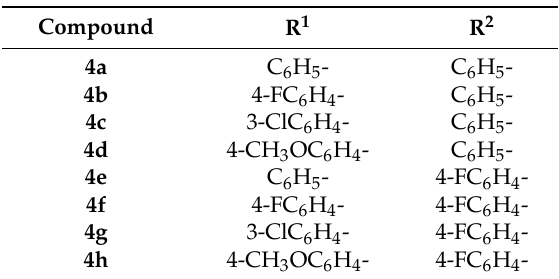
Table 1. Designation of R 1 and R 2 for products 4a – h .